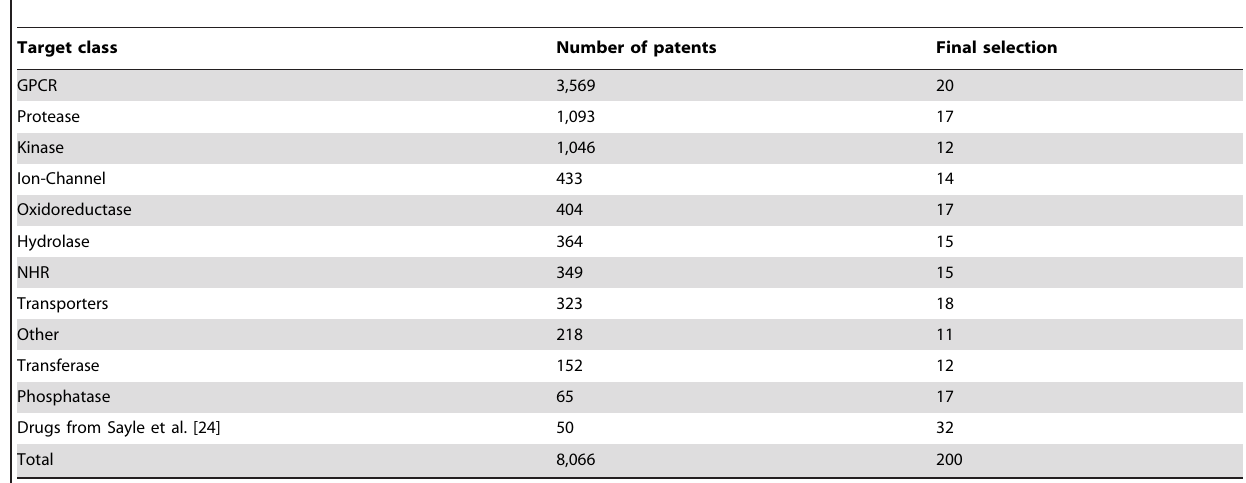
Table 1. Target class distribution of the 8,066 patents from which the final set was drawn.